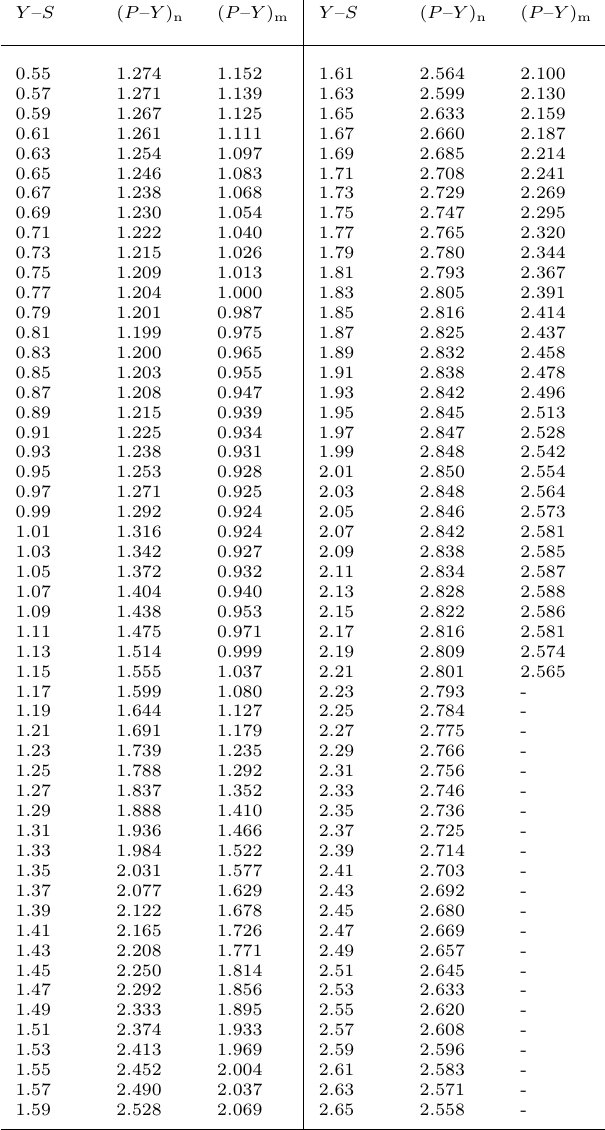
Table A1 . P – Y vs. Y – S relations for luminosity class